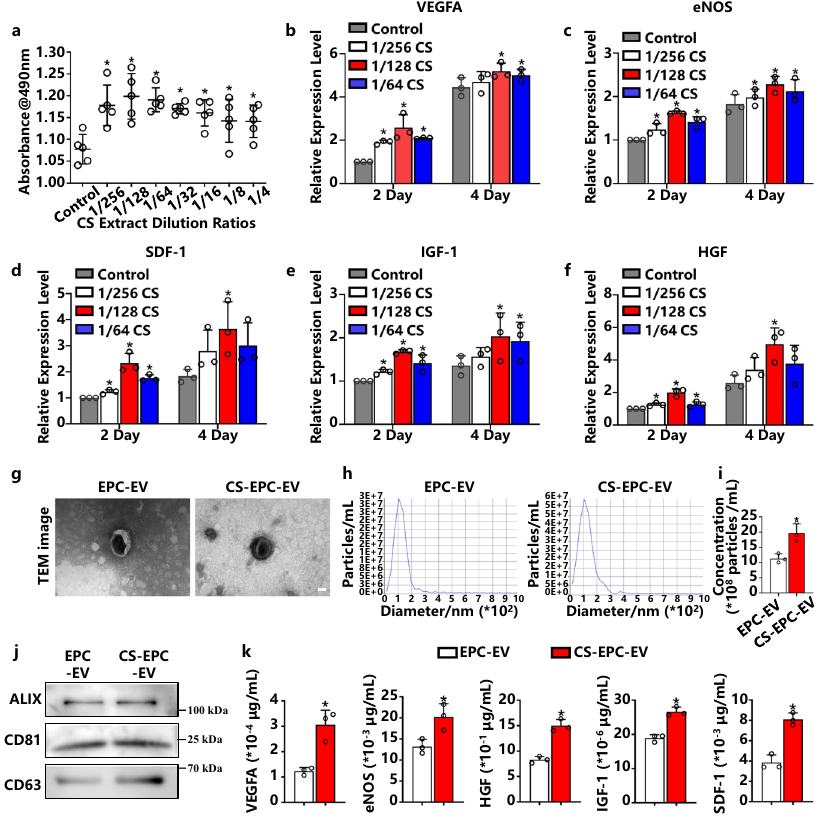
Fig. 2 | Activation of EPCs to secrete highly bioactive EVs by silicate ions (CS- EPC-EV) or normal culture medium (EPC-EV). a The effect of different con- centrations of CS extracts on the proliferation of EPCs was tested by 3-(4,5-dime- thylthiazol-2-yl)-5-(3-carboxymethoxyphenyl)-2-(4-sulfophenyl) − 2H-tetrazolium (MTS) ( n =5, biological replicates per group) * p <0.05 vs. the control. b – f The expression of proangiogenic genes was measured by quantitative reverse tran- scriptase Polymerase Chain Reaction (qRT ‒ PCR) on Day 2 and Day 4 in EPCs cul- tured in 1/256, 1/128, and 1/64 dilutions of ( b Vascular endothelial growth factor A, VEGFA; c Endothelial nitric oxide synthase, eNOS; d Stromal cell-derived factor 1, SDF-1; e Insulin-like growth factor 1, IGF-1; f Hepatocyte growth factor, HGF) ( n =3, biological replicates per group). * p <0.05 vs. the control. g Transmission electron microscopy (TEM) image of EPC-EVs, scale bar=50nm, ( n =3 independent